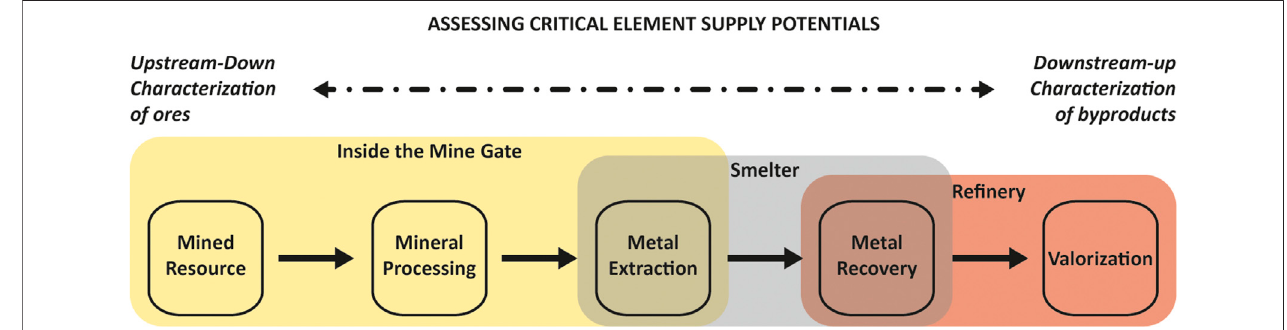
FIGURE 3 | Generalized major materials fl ows by process in the mining-smelting-re fi ning value chain with each process representing an opportunity to transport critical elements for downstream byproduct recovery as well as the challenge of integrating critical element deportment across multi-step, often global and multi- company value chains. The color polygons illustrate the potential, present-day silos between different operations in the value chain. Mineral processing liberates and concentrates economic metals and minerals from mined mineral resource (Lottermoser, 2010) for metal extraction, which collects metals from mineral concentratesandremovesganguemineralsandmetals(Jiang,2017).Dependingonthestructureoftheminingoperationthesetwostepscanoccurinsidetheminegate orbothinsideandoutsidetheminegate.Metalrecoverypuri fi esthemixtureofextractedmetalsandcompoundsintoasoughtafterchemicalform(Spoorenetal.,2020) withimpurities,suchaschalcophilecriticalelements,reportingtometallurgicalwastesandresiduesthatthancanberecovered(i.e.valorization;Binnemansetal.,2015). Depending on the re fi nery both primary metal recovery and byproduct metal (i.e., Au) semi-metal (i.e., Te) or chemical compound (i.e., sulfuric acid) recovery will occur within an operation or metallurgical wastes/residuals are sold to an external operation for processing and recovery of byproducts (i.e., saleable copper anode slimes).